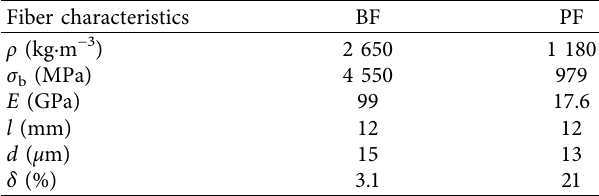
Table 1: Material properties of fibers.